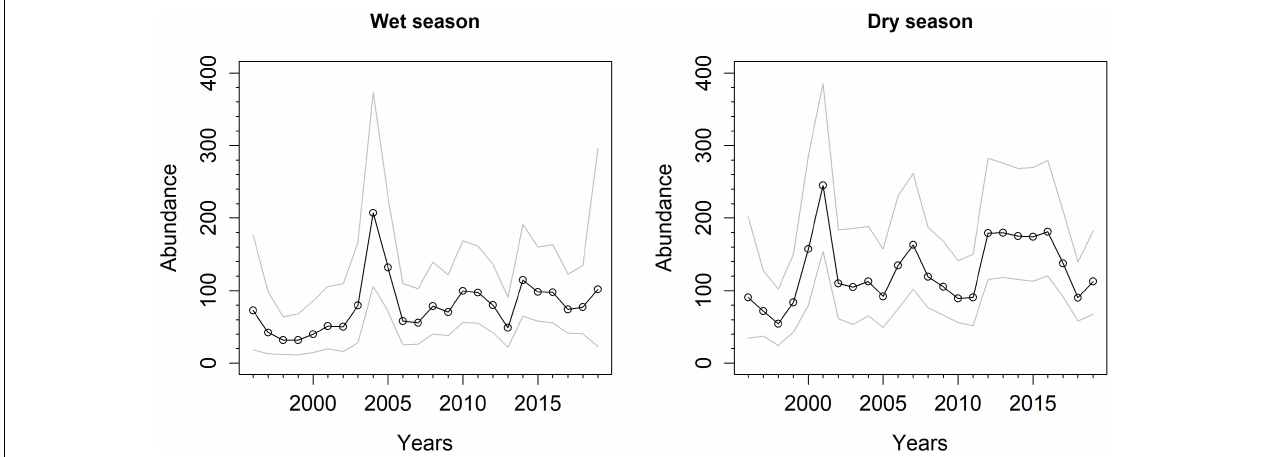
FIGURE 6 | Time series of population index estimates from 1996 to 2019 during the wet and dry seasons. Values are Bayesian posterior means (points) and 95% credible intervals (gray lines). For the wet season, the index represents the abundance for South Lantau, Po Toi, and Ninepins strata. For the dry season, the index represents the abundance for South Lantau and Lamma strata.